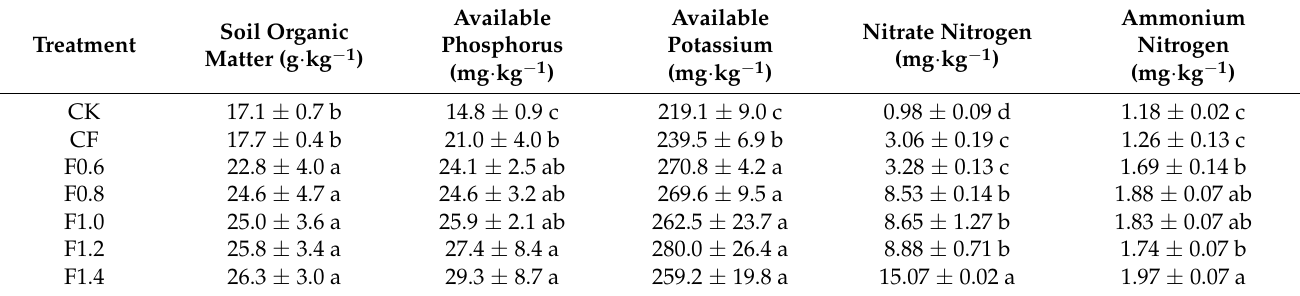
Table 3. Effects of different fertilization patterns on soil nutrients in cotton field